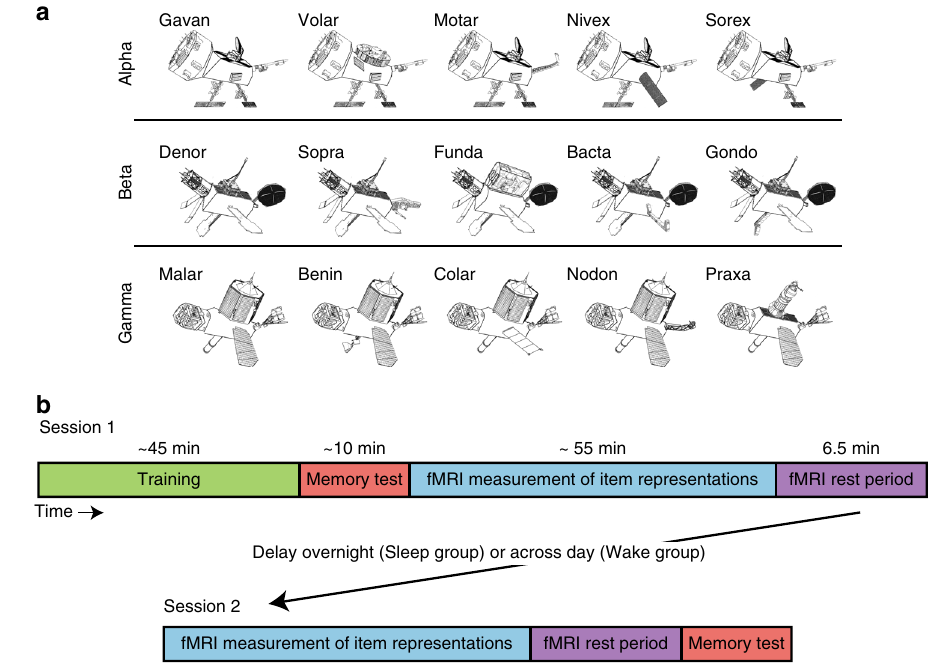
Fig. 1 Stimuli and design. a Examples of stimuli presented from the three classes Alpha, Beta, and Gamma, labeled with unique code names. Satellites were built randomly for each participant, using the same category structure. b Sessions 1 and 2 procedures for all participants, with delay between sessions either overnight or across day depending on